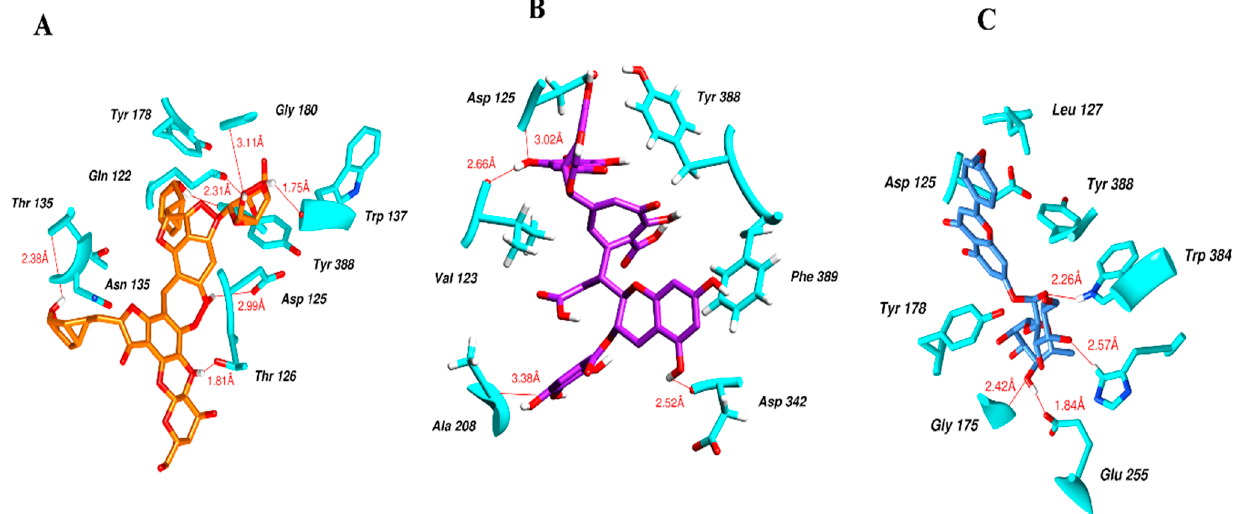
Figure 5. Docking interactions between ( A ) methylenebisphloridzin, ( B ) thearubigin, and ( C ) for- tunellin and the RmAChE1 protein. The center part of these sub fi gures represent the ligand sur- tunellin and the RmAChE1 protein. The center part of these subfigures represent the ligand sur- rounded by the interacting amino acids. rounded by the interacting amino